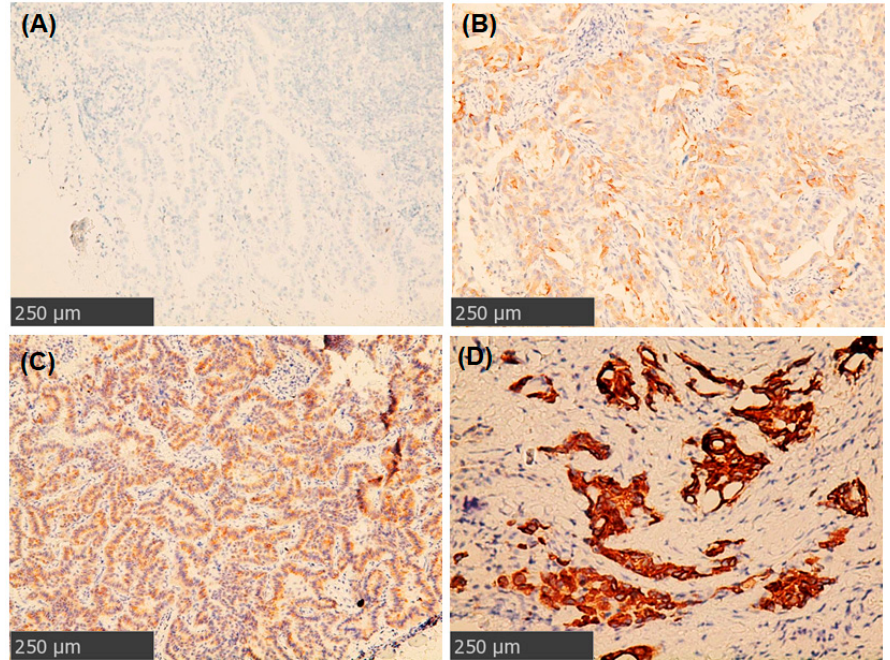
Table 2. Relationship between ROS1 and EGFR in lung cancers.